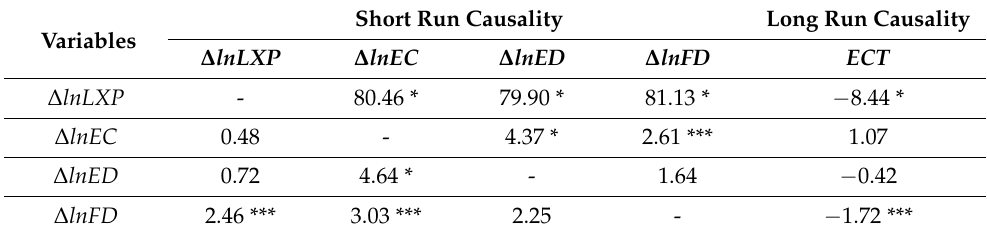
Table 8. Causality Results for Health Outcomes (Life Expectancy).